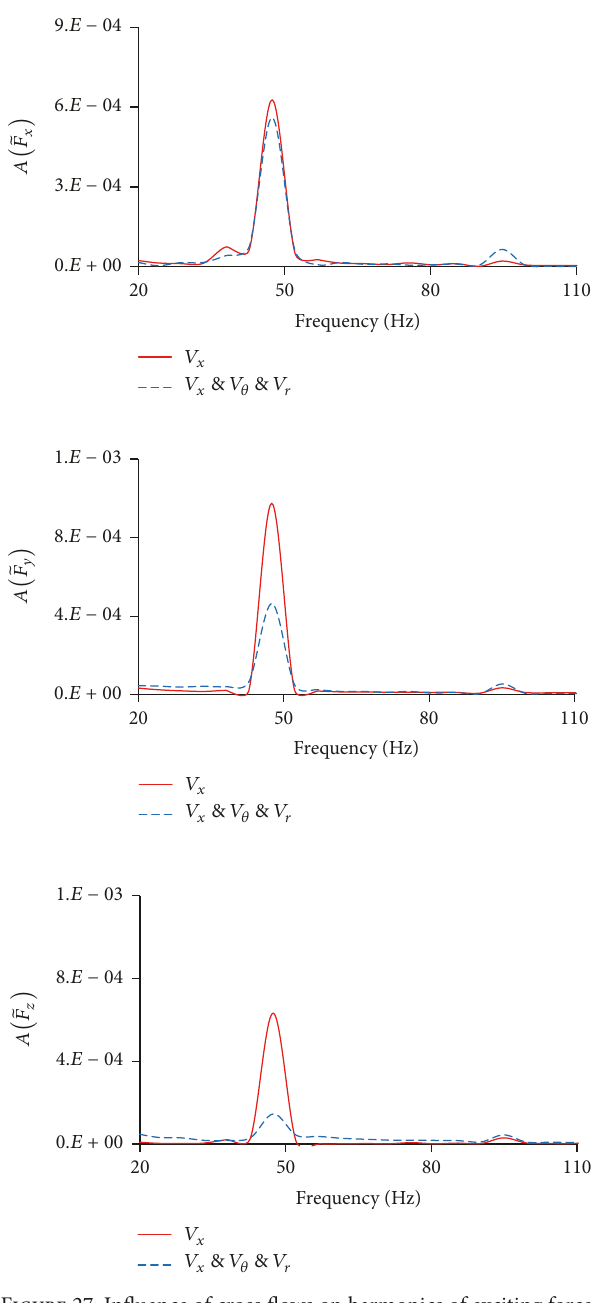
Figure 27: Influence of cross flows on harmonics of exciting forces of the whole